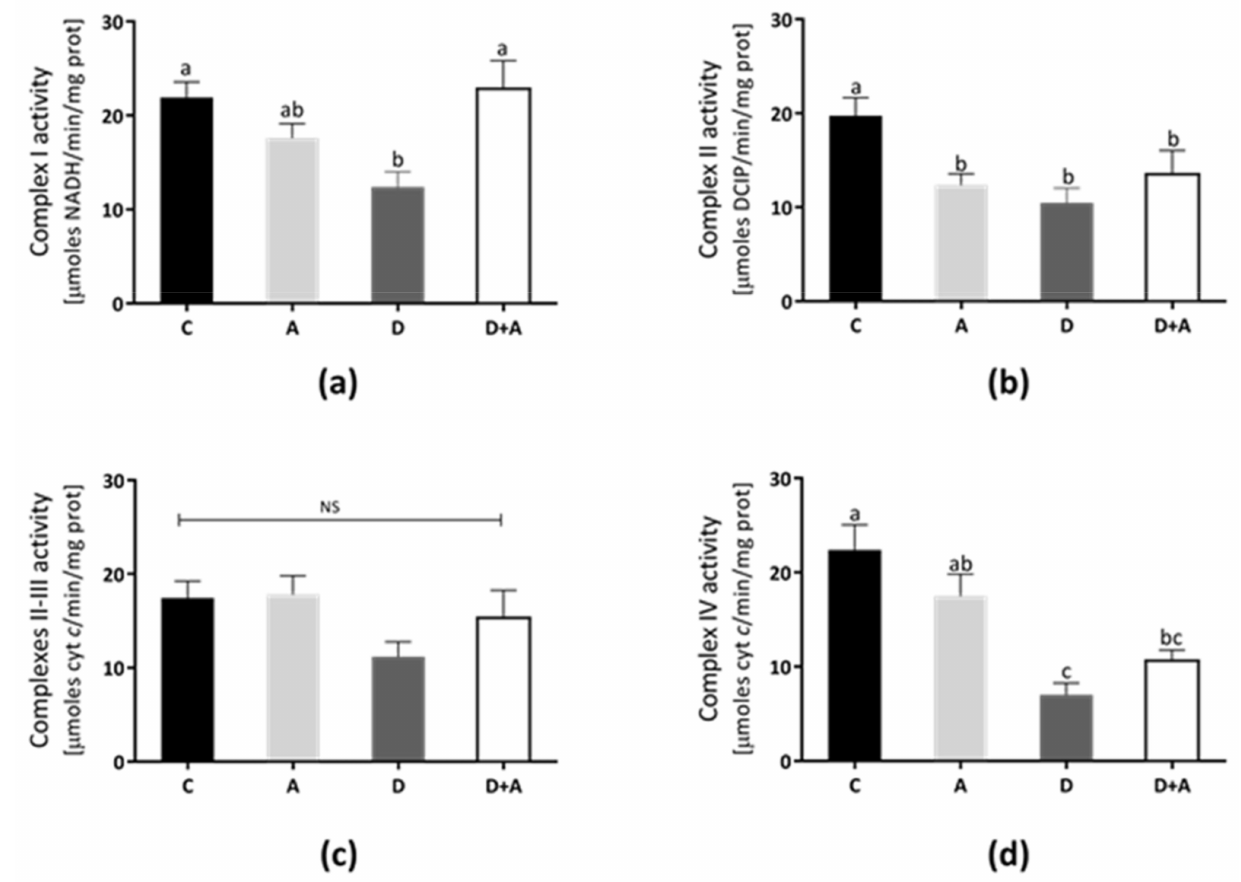
Figure 4. Effect of apocynin on enzymatic activities of complexes of the electron transport chain (ETC) in heart mitochondria. ( a ) Complex I activity. ( b ) Complex II activity. ( c ) Complexes II–III. ( d ) Complex IV. Different letters indicate significant differences between groups, ns: Not significant, ( p ≤ 0.05) by one-way ANOVA with Tukey post hoc test. Values represent means ± SEM. Control group, C, normoglycemic + apocynin group, A, diabetic group, D, and diabetic + apocynin group,